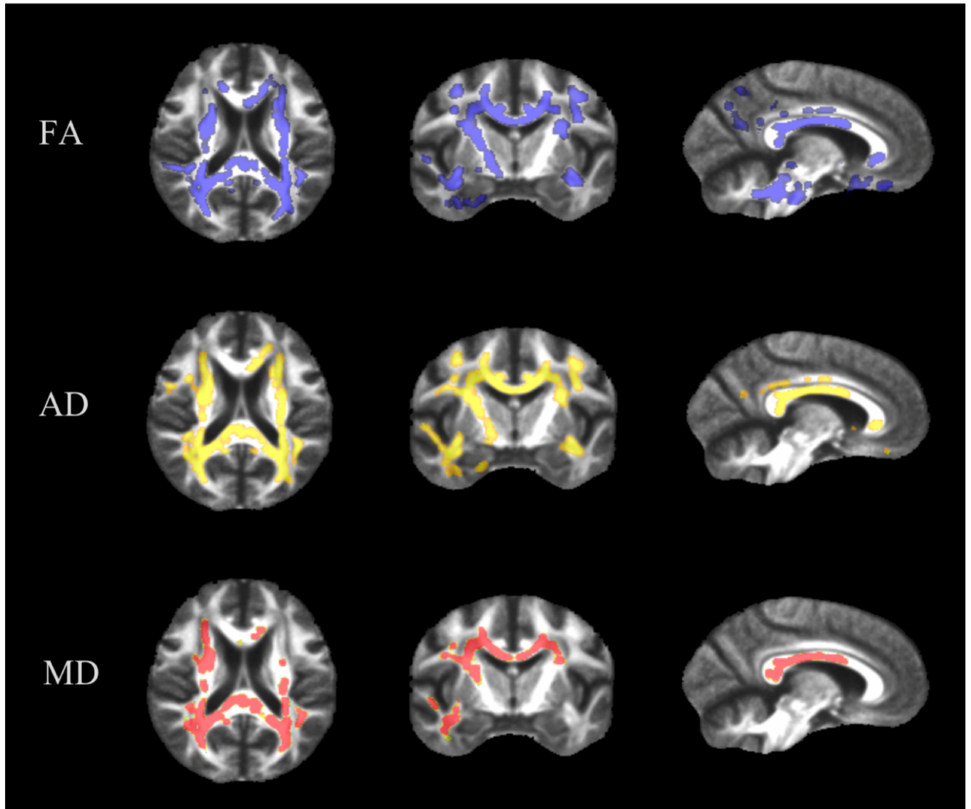
Figure 1. Whole brain voxel-wise analysis of white matter changes in HSP using tract-based spatial statistics (TBSS). TBSS of the brain of patients with pure HSP revealed reduced fractional anisotropy (FA, blue), increased axial di ff usivity (AD, yellow) and increased mean di ff usivity (MD, red) in comparison to controls. Displayed on mean FA template. Significant values ( p < 0.05, cluster threshold correction for multiple comparison) are shown in blue, yellow and red